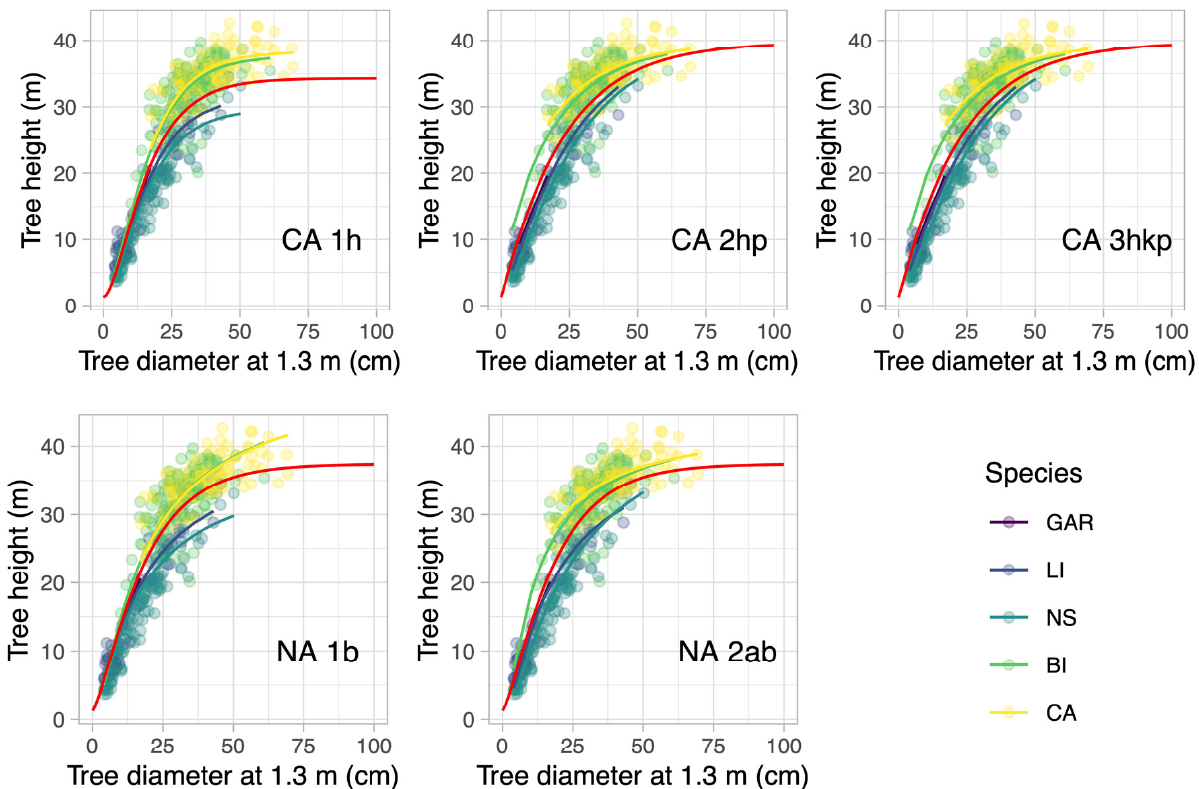
Figure 3. Mixed-effects models for the dataset of the managed forest in Laeva. The nomenclature of the models is the same as described in Figure 2. Similarly, the colors denote the species subject to the fitting, and dots are data and lines the modeled relationships per species. The red line denotes again the overall relationship found by the nonlinear mixed-effects model fit to the data. Tree species are as follows: BI = silver birch and downy birch; NS = Norway spruce; GAR = gray alder; LI = lime family; CA = common aspen.